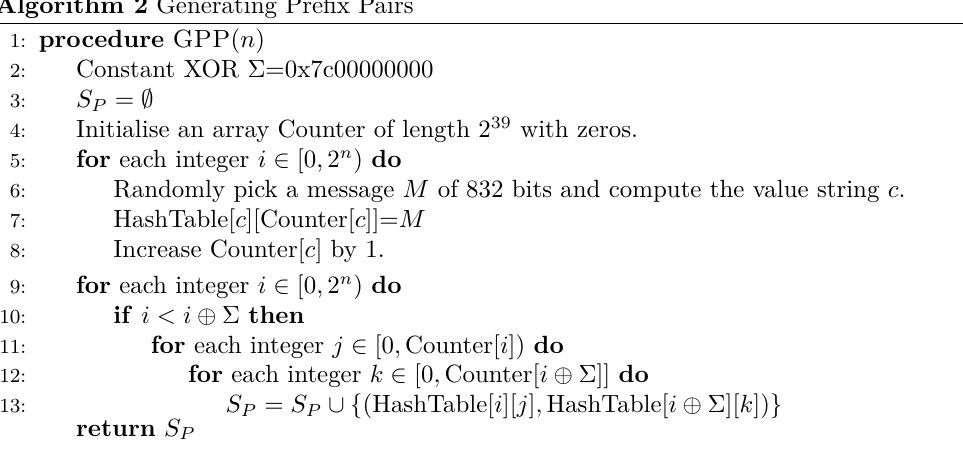
Algorithm 2 Generating Prefix